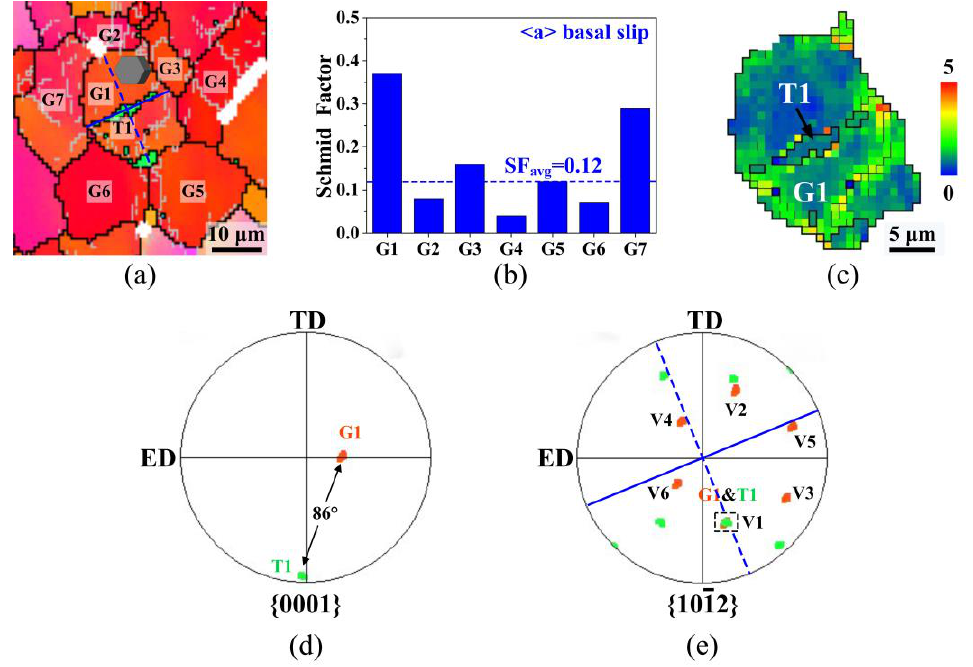
Figure 7. ( a ) EBSD map of the framed area by blue dotted border in Figure 4c; ( b ) Schmid factors of basal slip in G1–7; ( c ) KAM map of G1 and T1; ( d ) shows {0001} pole figure of G1 and T1; and ( e )